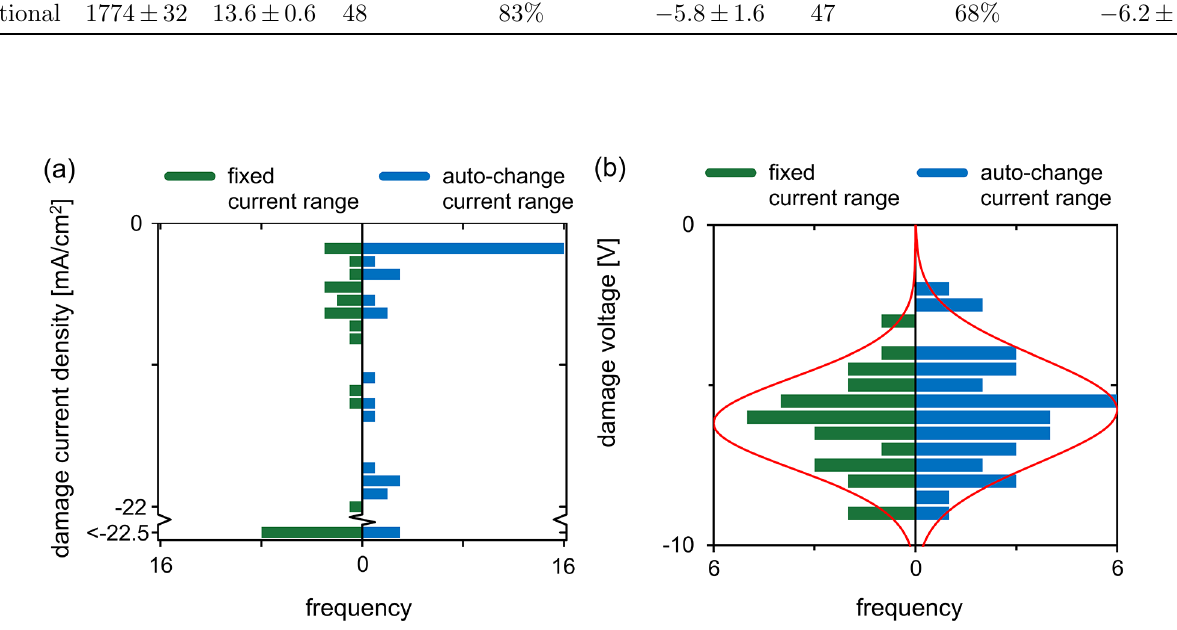
Fig. A.1. (a) Histograms of damage current density in dark reverse bias sweeps with on the left results of fi xed current range and on the right the auto-change current range results. The last bin (bottom) represents the number of cells with a damage current density smaller than (cid:1) 22.5mA/cm 2 . (b) Histograms of damage voltage in dark reverse bias sweep and the normal distribution curve based on average and standard deviation for measurements performed with fi xed and auto-change current